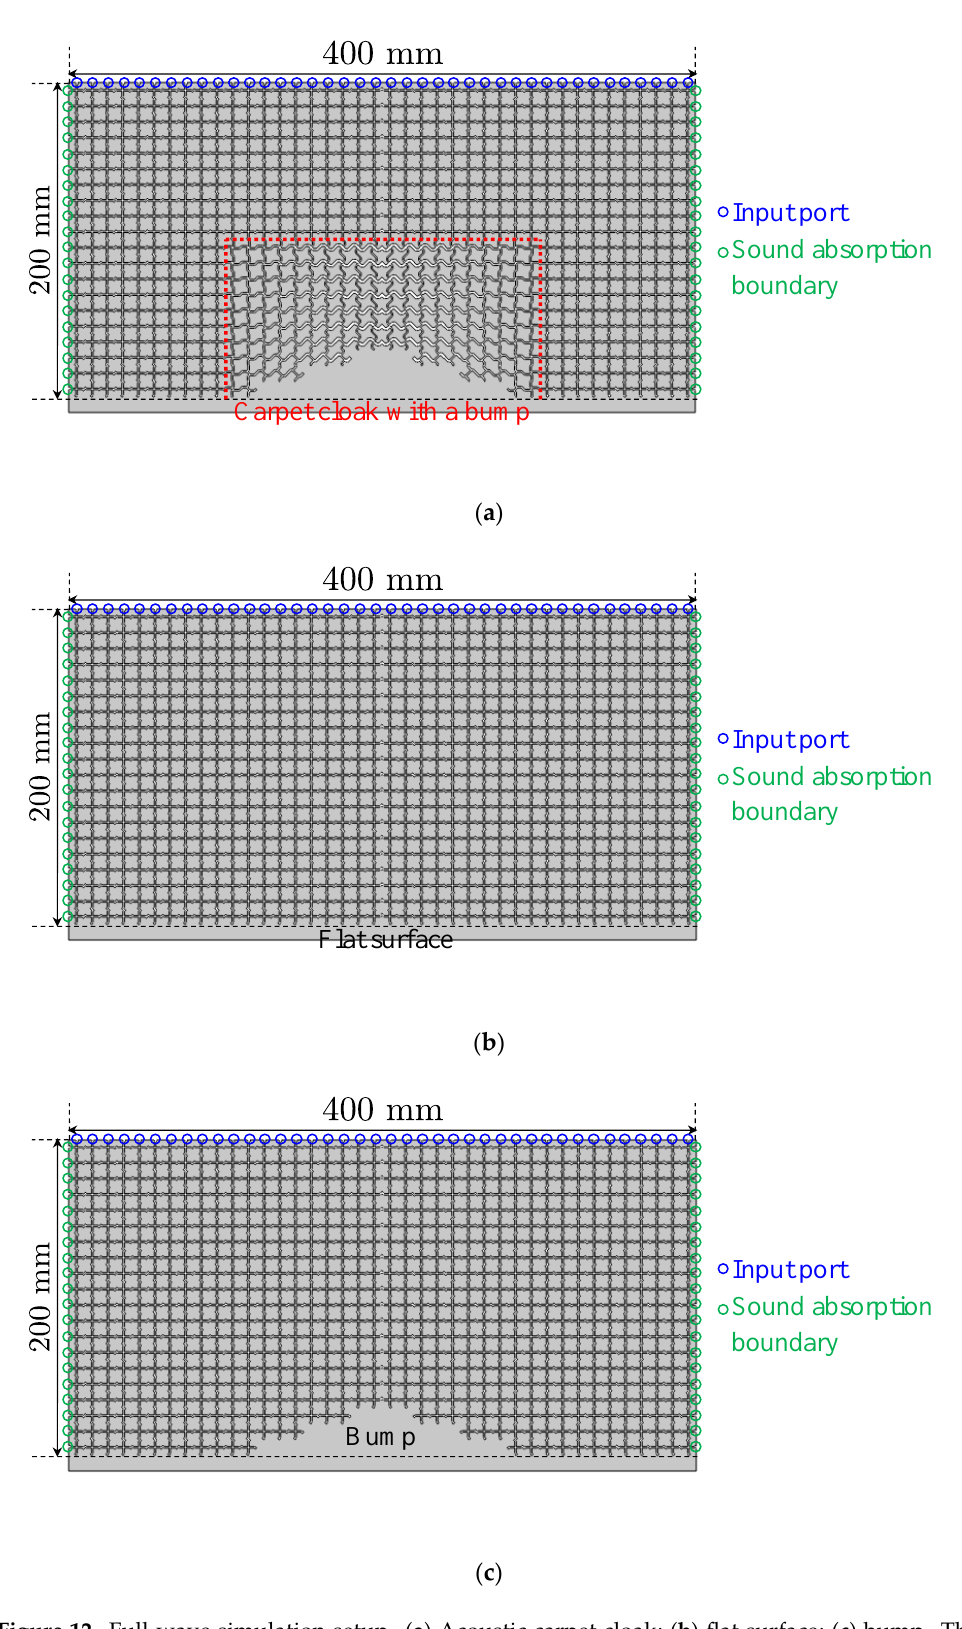
Figure 12. Full-wave simulation setup. ( a ) Acoustic carpet cloak; ( b ) flat surface; ( c ) bump. The designed structures in Figure 10a-c are placed at the center of the bottom of the background medium area (400 mm × 200 mm). The bottom boundaries are set as the rigid body walls.